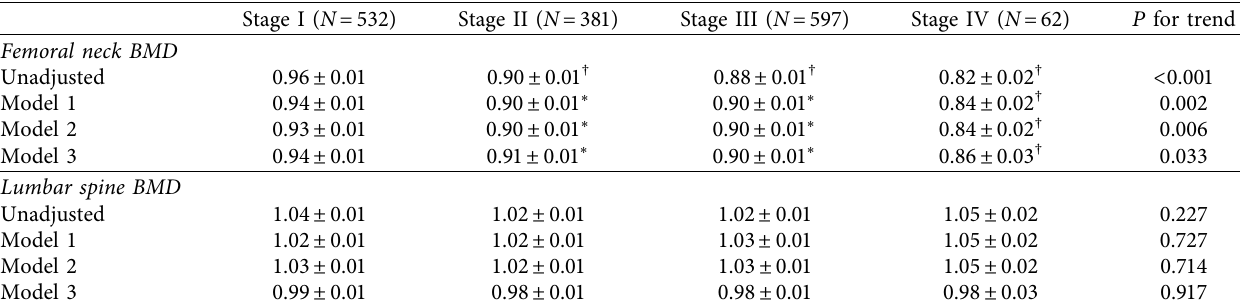
Figure 1: Scatterplot, Pearson correlation, and partial correlations between BMD and eGFR in total population, males, and females (a, b, and c, respectively). BMD is presented by a logarithmic scale along the y -axis and eGFR along the x -axis. Regression lines are shown with 95% CIs (orange lines) and 95% prediction interval (yellow lines). BMD, bone mineral density; CKD: chronic kidney disease; eGFR: estimated glomerular filtration rate. Table 3: Mean BMD (g/cm 2 ) according to the severity of